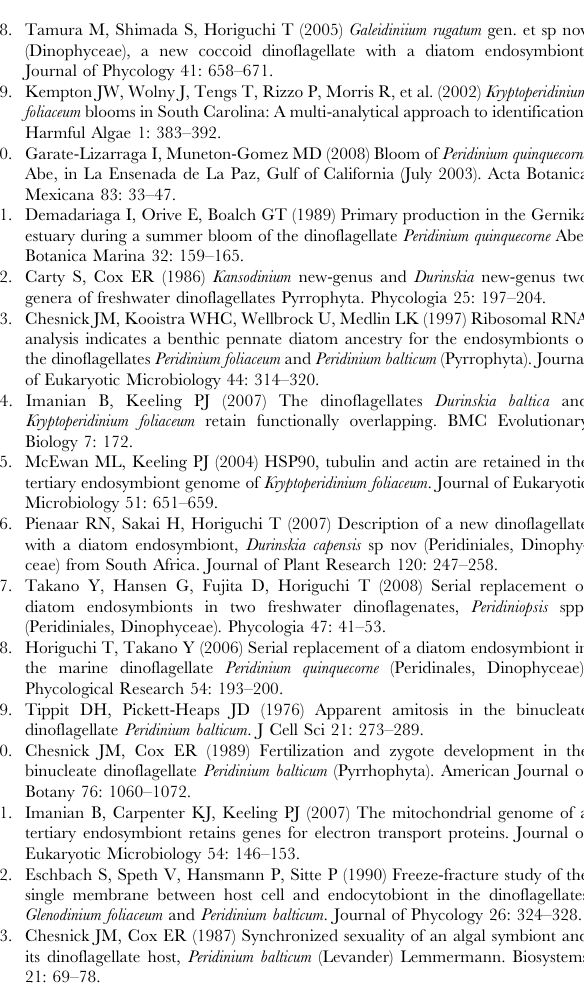
Figure S1 Gene size differences. Pairwise comparisons of gene size differences (larger than 5 bp in at least 2 of the 3 species) in the plastid genomes of Phaeodactylum tricornutum (Pt), Durinskia baltica (Db), and Kryptoperidinium foliaceum (Kf). Found at: doi:10.1371/journal.pone.0010711.s001 (0.92 MB EPS) Figure S2 Conserved residues found in TyrC. The conserved residues found in the TyrC recombinase encoded in the plastid genomes of Kryptoperidinium foliaceum and other site-specific tyrosine recombinases. The sequences of Heterosigma akashiwo ’s TyrC were manually added to the Conserved Domain Database (CDD) alignment for K. foliaceum ’s TyrC. The conserved residues with specific functions are marked with a number sign ( # ) above the alignments. Shaded residues indicate invariable sites among all the recombinases in the alignment, and the long rectangular boxes highlight conserved sites among all the recombinases in the alignment except one.